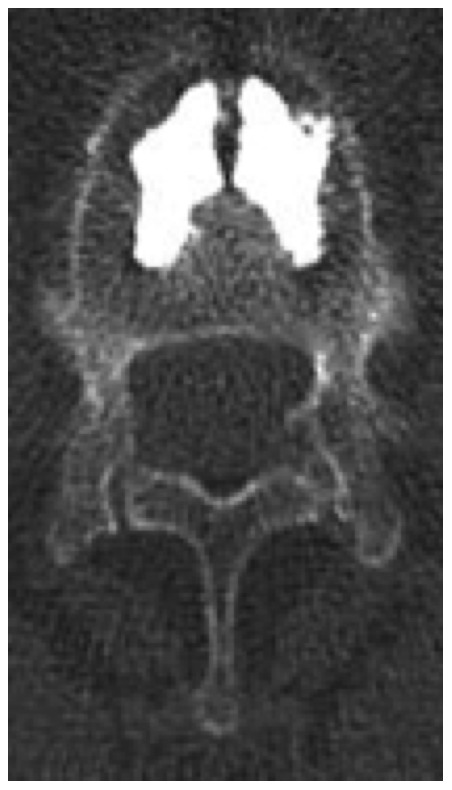
Case presentation with Osseofix® system.Radiological case report. Axial slice CT of L1 after stabilization with Osseofix® system.